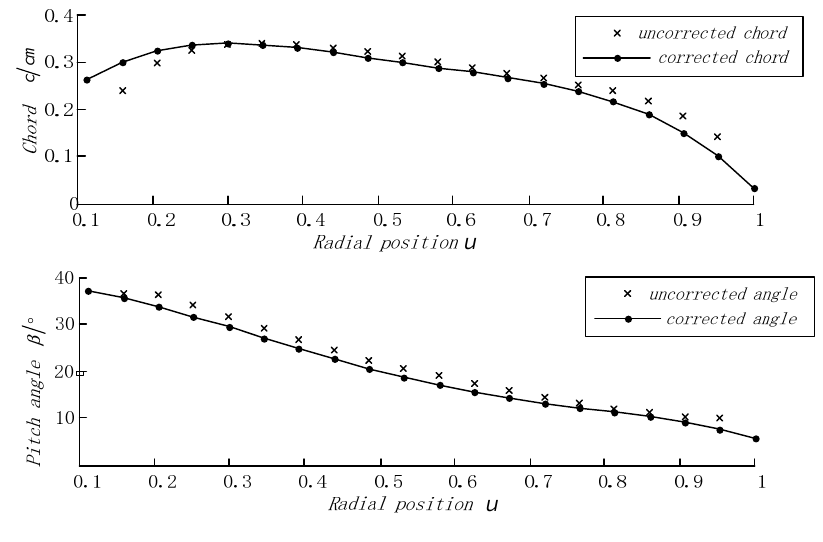
Figure 8. The chord length and pitch angle of Blade I.